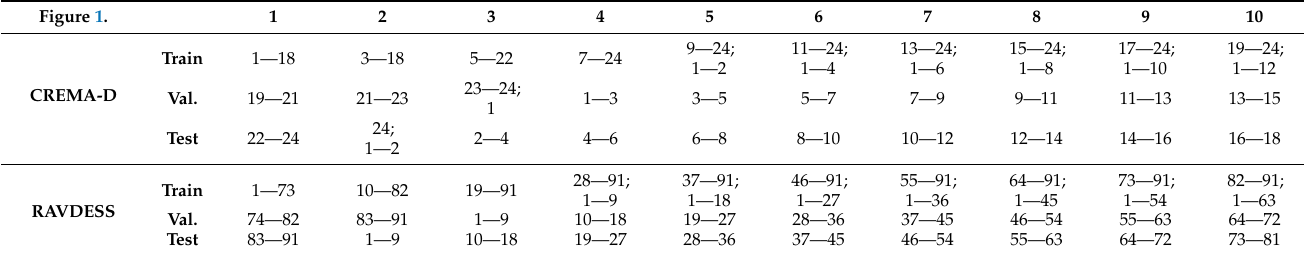
Table 1. The 10-fold cross-validation scheme applied on the considered datasets. Figure